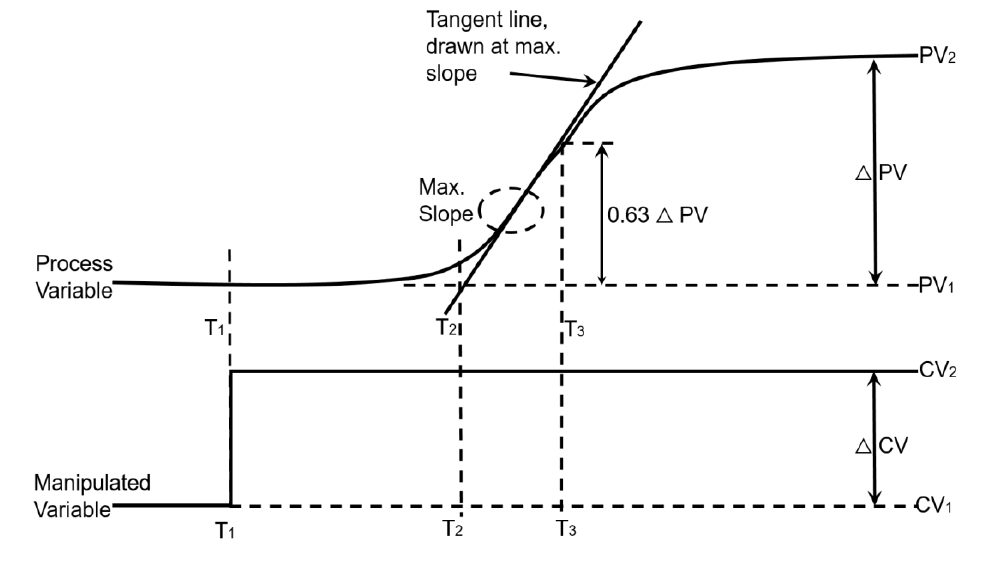
Figure 4. Response to step input.